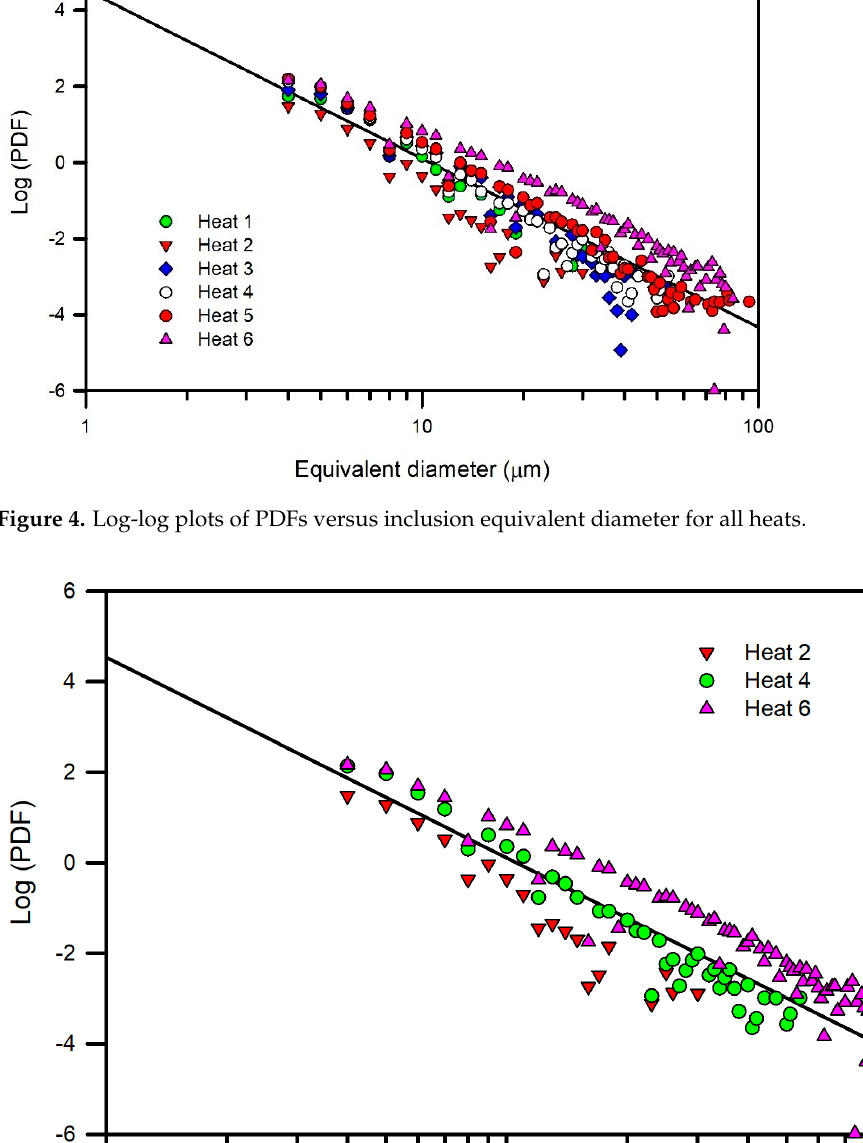
7 of 16 Figure 3. Evolution of the population density function PDF. The logarithmic representation of the calculated PDFs is shown in Figure 4. A general linear power law behavior, represented by a reference straight line plotted in the figure, was observed. The reference straight line was estimated from the totality of the PDF data. The most notable deviations from the reference line corresponded to Heats 2 and 6, re- spectively, whereas the other heats fit better to the reference line. To clarify the observed behavior, the logarithmic representations of the PDFs of Heats 2 and 6 are shown in Figure 5, in which the data of Heat 4 were included because of its better fit to the reference line. Heat 6 presented both a higher frequency of inclusions and a larger inclusion size; in con- trast, Heat 2 presented a lower frequency of inclusions and a smaller inclusion size, and